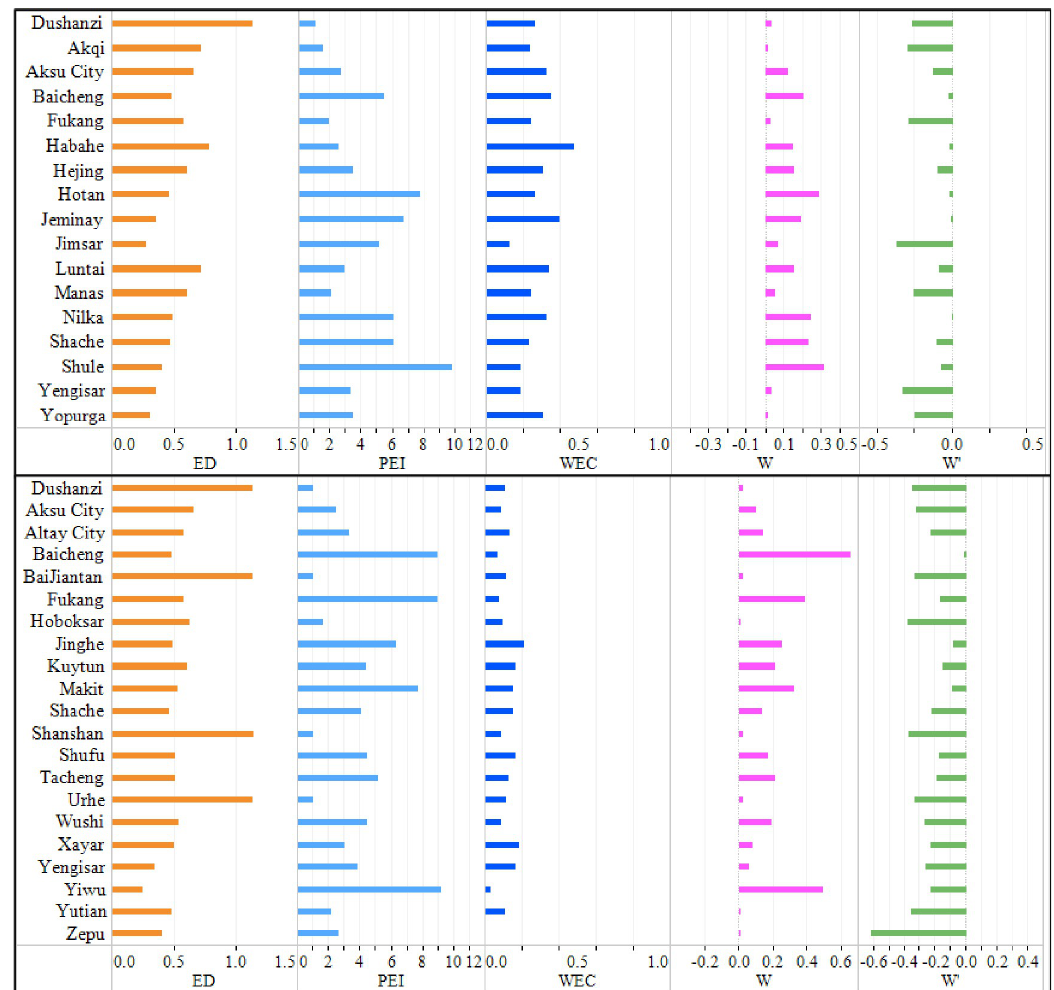
Fig 7. Causes of decomposition of water pollutants in counties and cities with a “poor ! good” change trend.